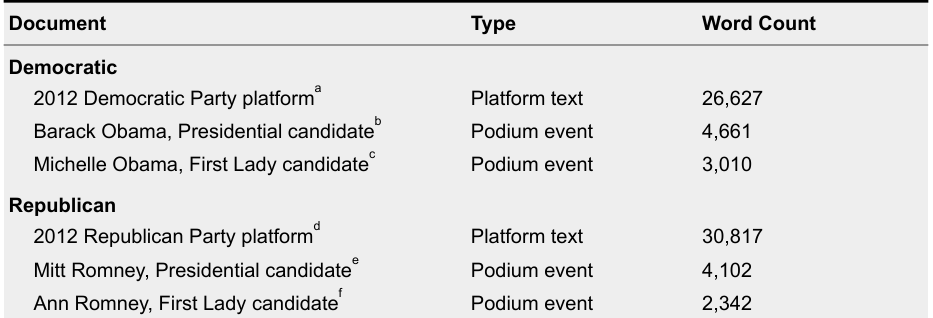
Details of Data